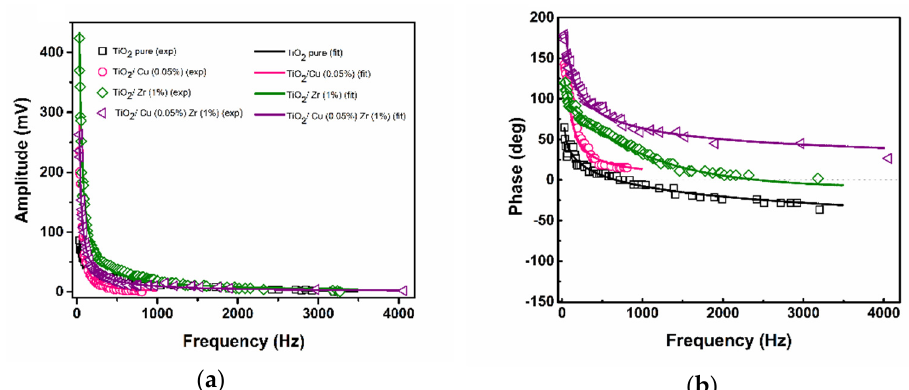
Figure 9. The amplitude ( a ) and phase ( b ) of BDS signal for unmodified and Zr- and/or Cu-modified TiO 2 samples. Points represent the experimental data, whereas continuous lines are the best linear fits to the experimental data by the model presented in [22]. The RSD% for the average of 3 measurements is 1–2%.